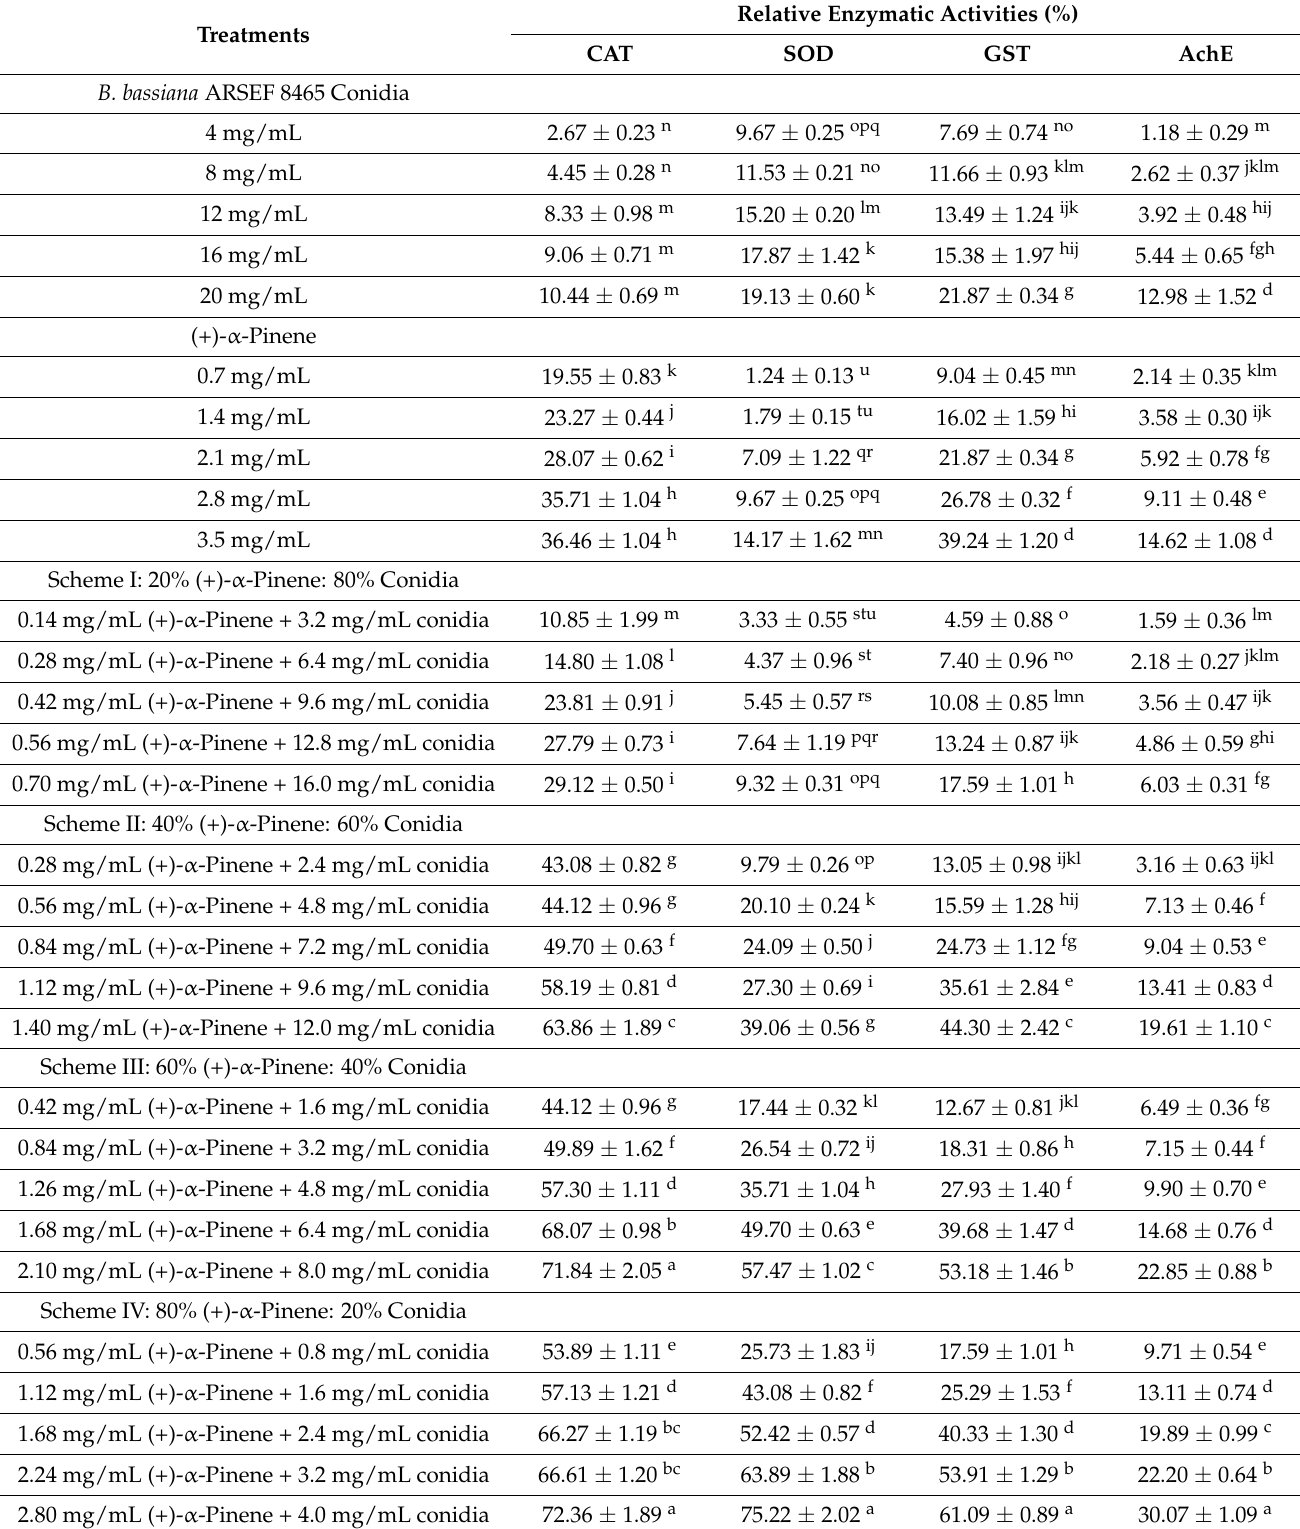
Table 6. Relative enzymatic activities of O. afrasiaticus fed on leaves treated with various proportions of (+)- α -Pinene and B. bassiana ARSEF 8465 alone or in different combinations for comparative host defense-related regulation analysis.